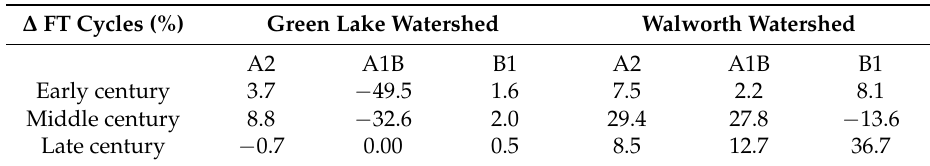
Table 5. Percent change in the number of soil freeze and thaw cycles from the base period for three future climate